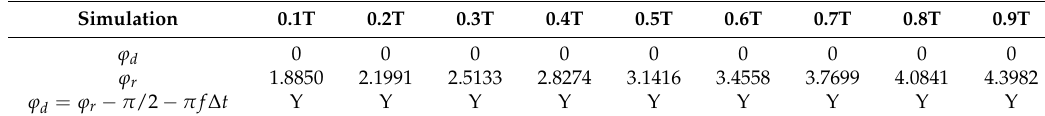
Table 2. The phases of simulated jitter displacements and registration errors at different imaging time intervals.